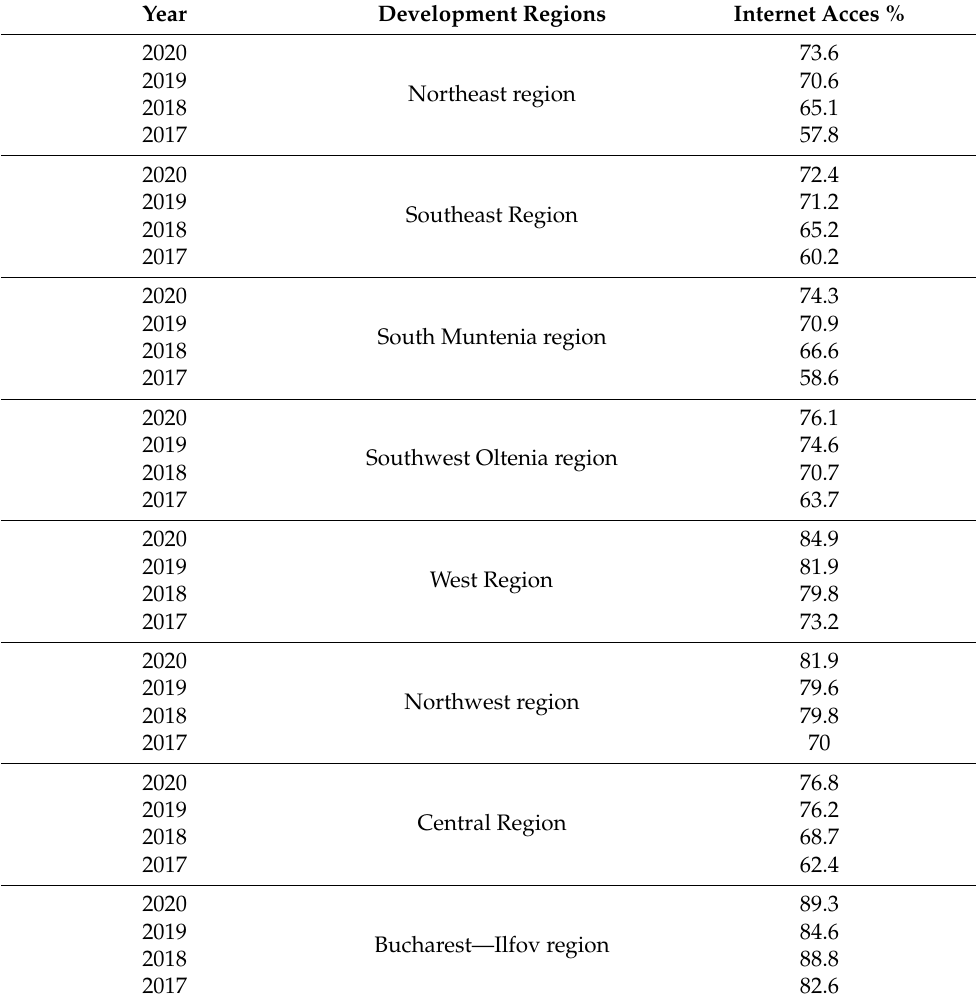
Table 7. The evolution of households that have access to the Internet at home, at the level of development regions. Development